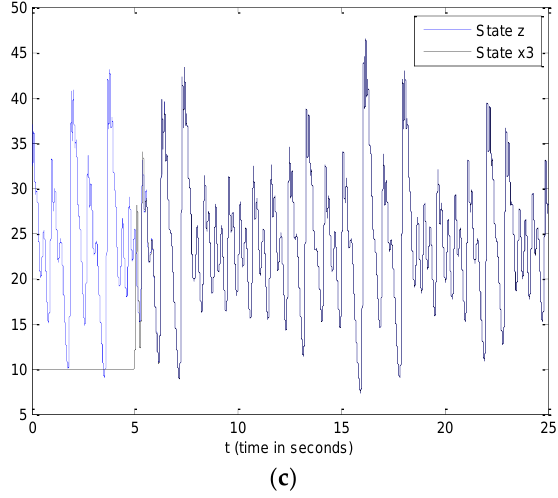
Figure 7. Time response plots of synchronized states of master and slave with α i = 0.9, i = 1, 2, and 3, and time delay τ = 5 s: ( a ) First state ( x − x 1 ) of master and slave; ( b ) second state ( y − x 2 ) of master and slave; ( c ) third state ( z − x 3 ) of master and slave.